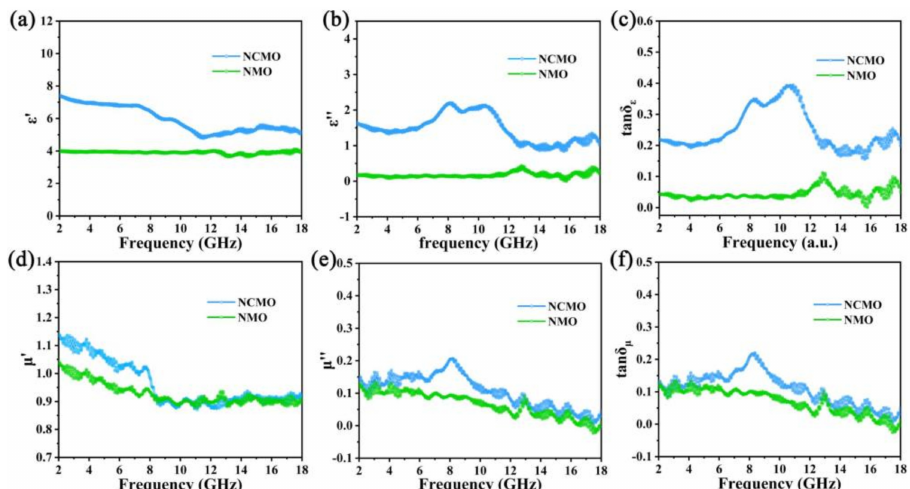
Figure 5. Frequency dependence of electromagnetic parameters of NMO and NCMO: ( a ) real part ( ε (cid:48) ); ( b ) imaginary part ( ε (cid:48)(cid:48) ); ( c ) dielectric loss (tan δ ε ); ( d ) real part ( µ (cid:48) ); ( e ) imaginary part ( µ (cid:48)(cid:48) ); ( f ) magnetic loss (tan δ µ